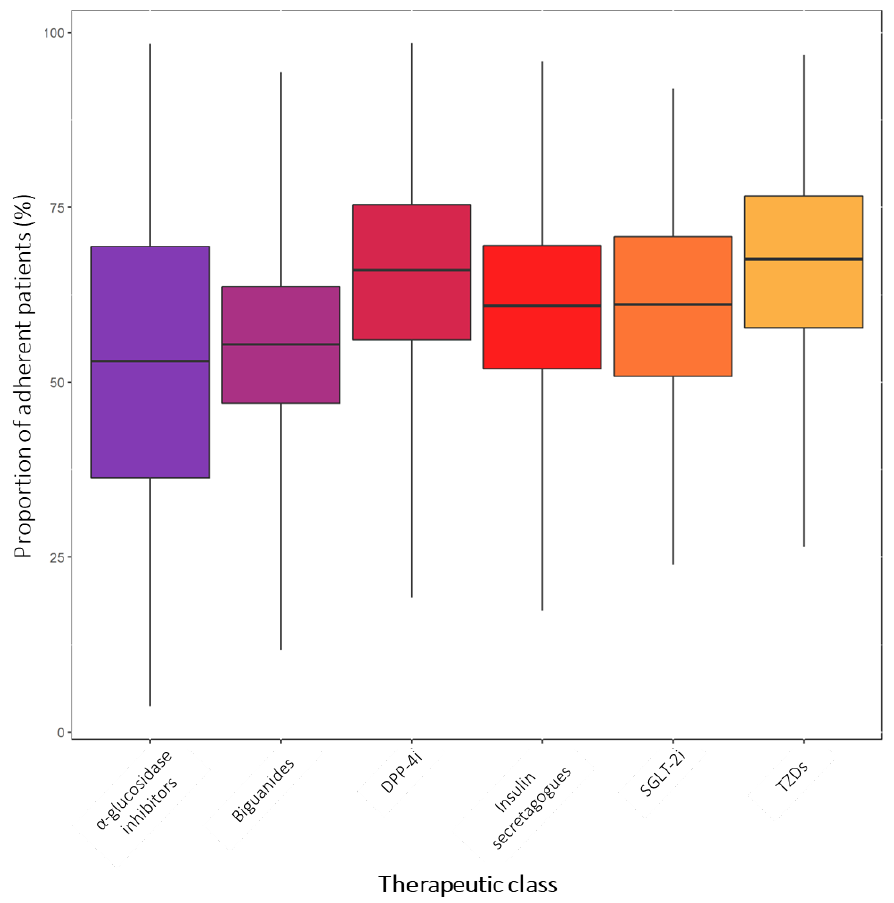
Figure 3. Boxplot representing the pooled proportions of adherent patients (expressed as a percentage) stratified by therapeutic class. The boxes represent the 95% confidence intervals of the proportions, while the whiskers extend for the 95% prediction interval.